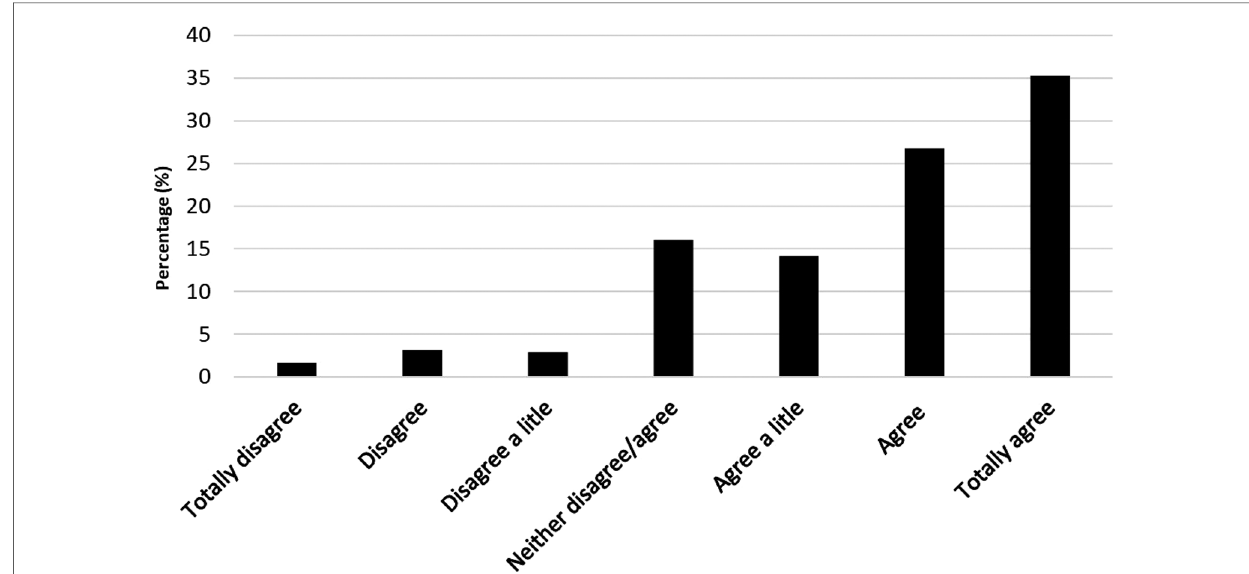
FIGURE 1 Distribution of answers to the statement: “ I experience being seen by the teacher in PE.